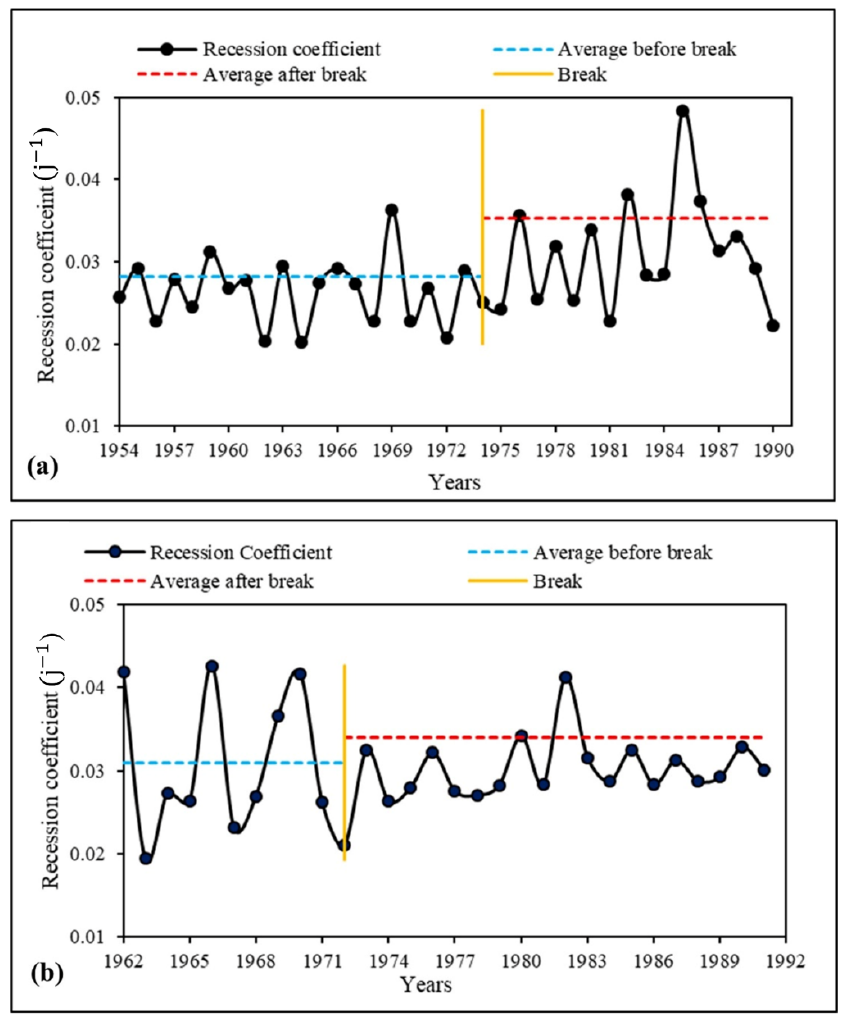
Figure 9. Variation of the dry-off coefficient at the Kara ( a ) and Kpéssidè ( b ) stations. At the Kara station (Figure 10a), the average annual water volumes mobilized by the aquifers vary between 0.09 and 0.56 km 3 ·yr − 1 before the break with an annual average of 0.32 km 3 ·yr − 1 . After the break, these values vary from 0.08 to 0.43 km 3 ·yr − 1 with an annual average of 0.25 km 3 ·yr − 1 . The water volume mobilized by the aquifers thus fell by 22% after the climatic break. At the Kpéssidè station (Figure 10b), the water volume mobilized fluc- tuates between 0.04 and 0.9 km 3 ·yr − 1 before the break with an annual average of 0.47 km 3 ·yr − 1 . After the break, the volume varies between 0.03 and 0.52 km 3 ·yr − 1 with an annual average of 0.3 km 3 ·yr − 1 . The decline rate is thus about 36%.